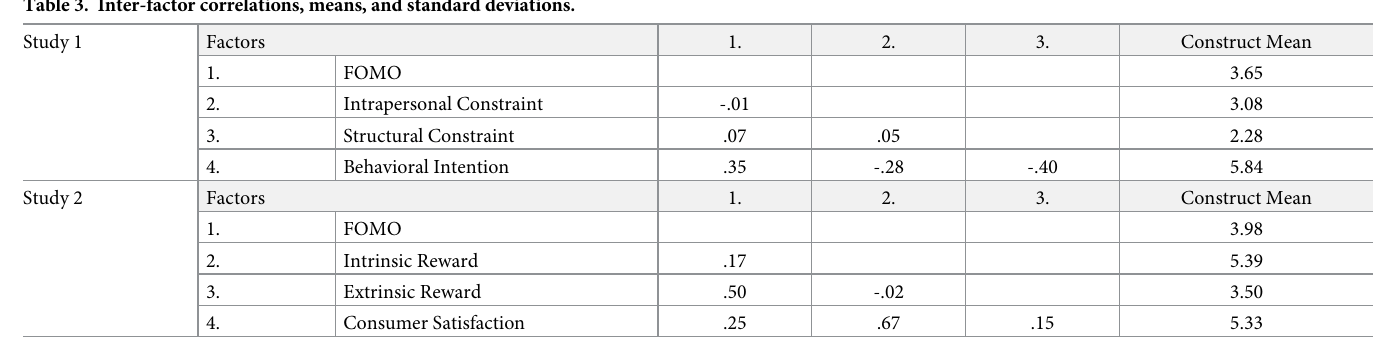
Table 3. Inter-factor correlations, means, and standard deviations.